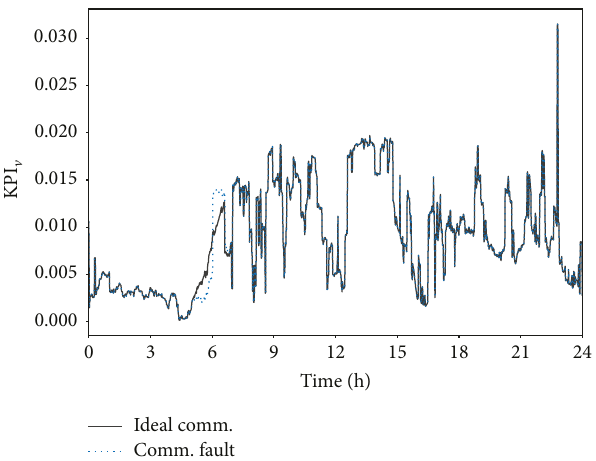
Figure 10: Comparison of voltage KPI for cosimulation with and without communication network